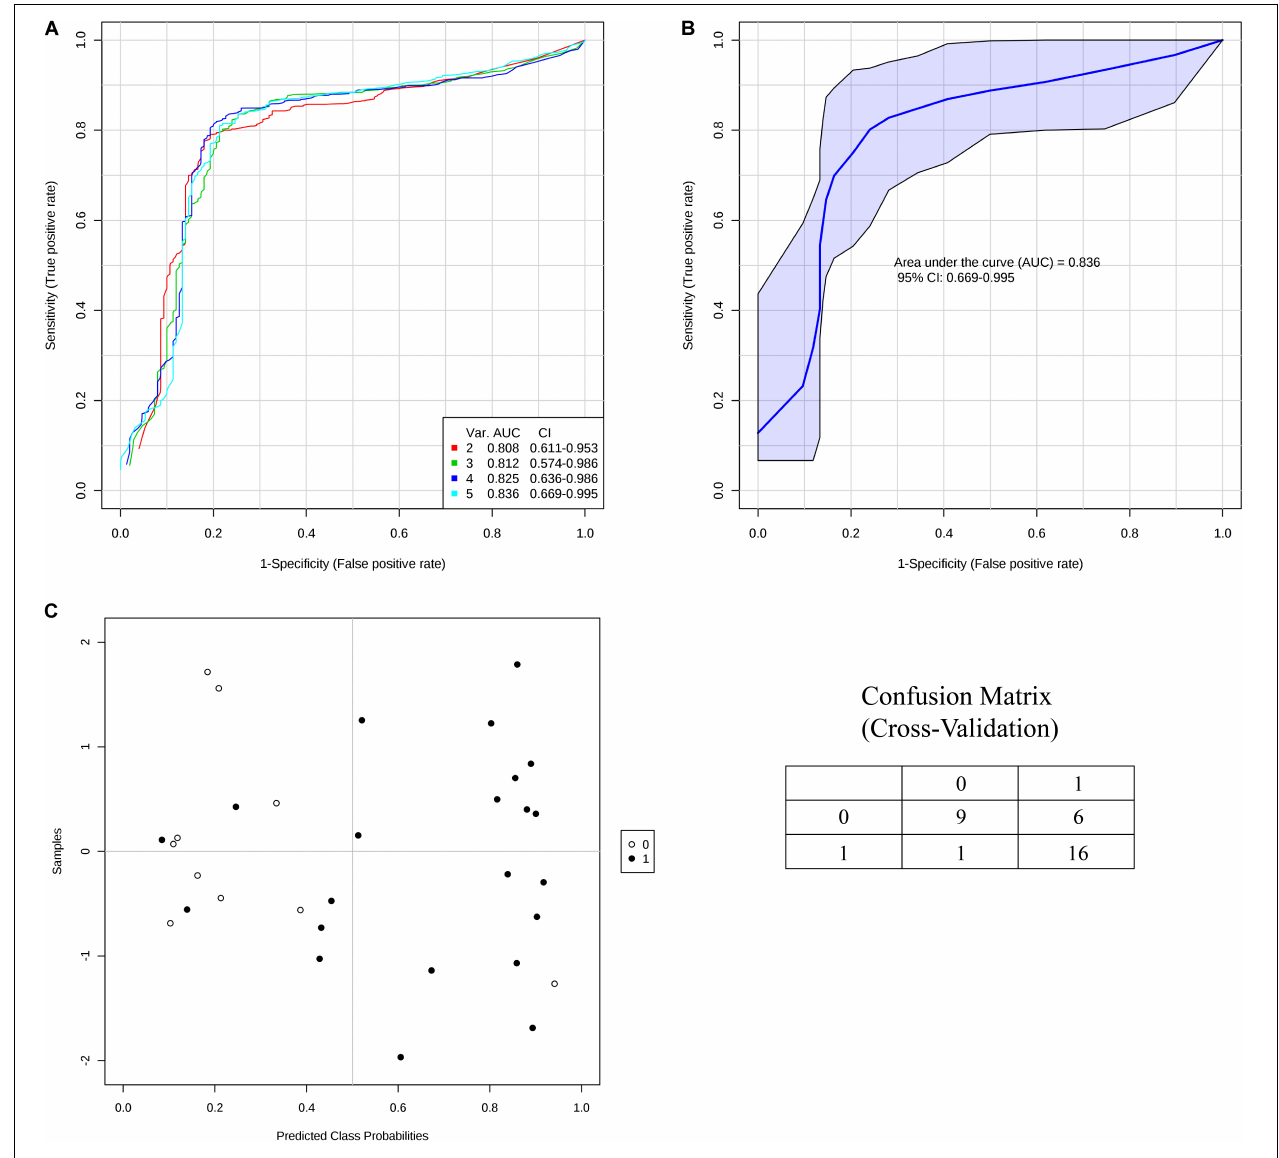
FIGURE 5 | Multivariate ROC Curve analysis. (A) Four models of multivariate ROC curves, each one built on a combination of 2, 3, 4, or 5 DE miRNAs. (B) Five miRNA model ROC curve with confidence intervals highlighted in blue. (C) Sample classification plot and confusion matrix generated from the five miRNA model ROC curve.